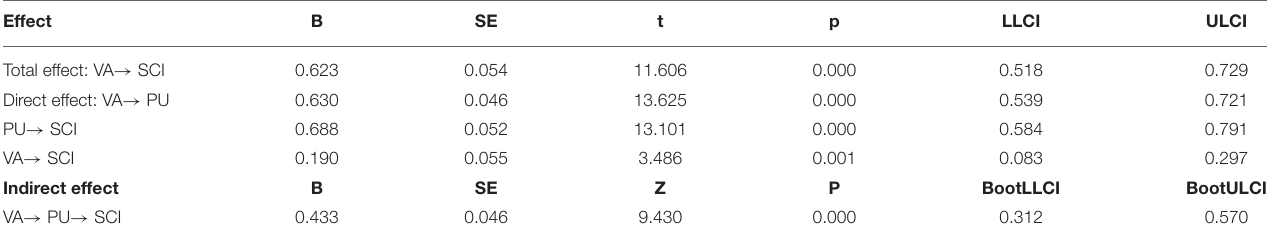
TABLE 3 | Mediation results—the indirect effect of VA on SCI via PU (PROCESS model 4, 95% CI). Effect B